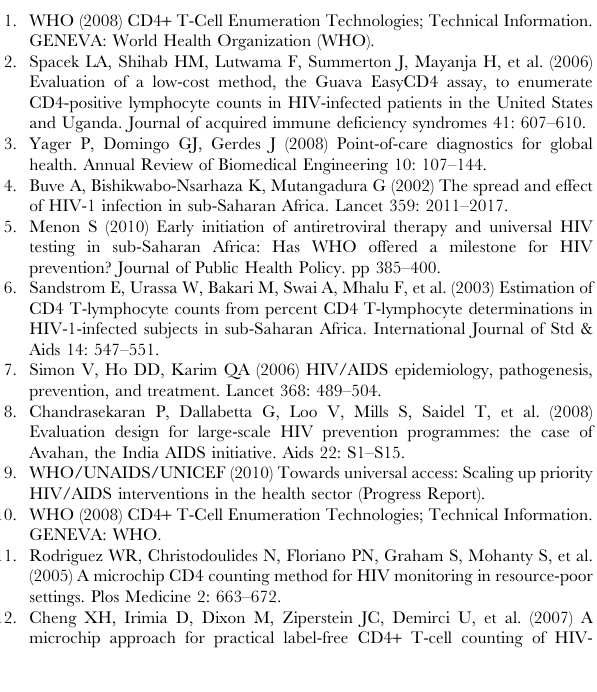
Table S2 Standard Operation Procedure (SOP) for surface chemistry in microfluidic chips at the point of care prior to blood testing. Table S3 Standard Operation Procedure (SOP) for blood testing at the point of care with CD4 counting microfluidic